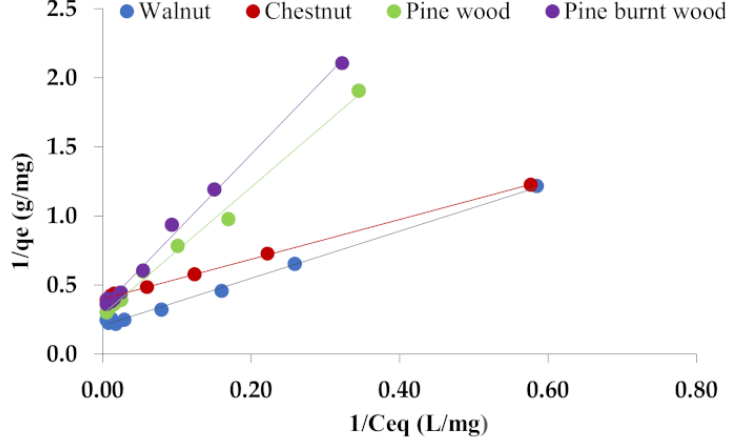
Figure 8. Langmuir isotherm model for nickel adsorption with nickel concentrations from 5 to 200 mg L − 1 and 100 mg of adsorbent.